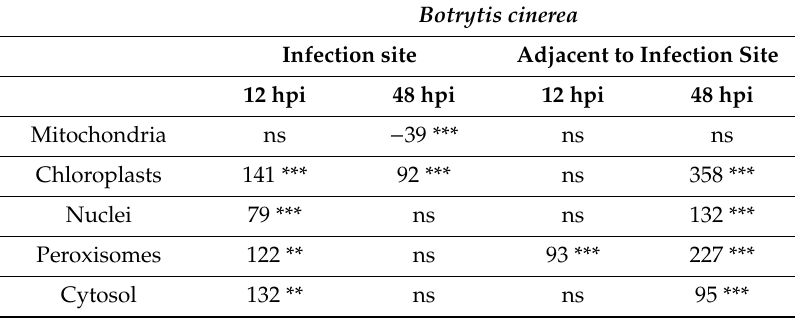
Table 1. Changes in percentage of subcellular glutathione contents in Arabidopsis infected with Botrytis cinerea . Glutathione contents were determined at di ff erent hours, post inoculation (hpi), in cells at the infection site (tissue underneath the drop containing spores), adjacent to the infection site, and compared to the control [52]. Significant di ff erences were calculated using the Mann-Whitney U-test; ** and ***, respectively, indicate significance at the 0.01 and 0.001 levels of confidence; ns = not significantly di ff